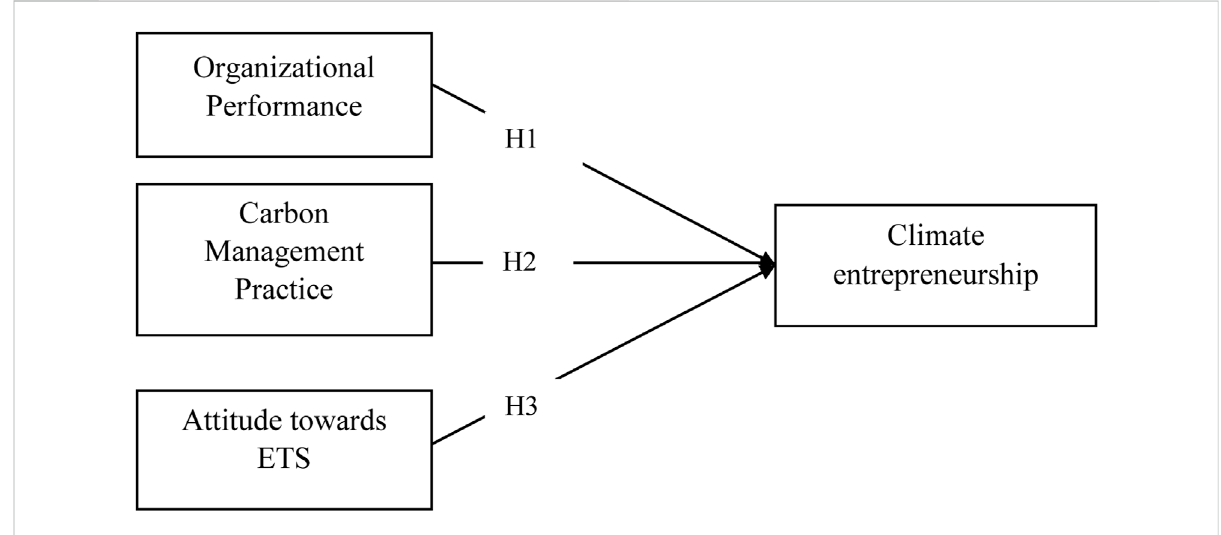
FIGURE 1 Theoretical research